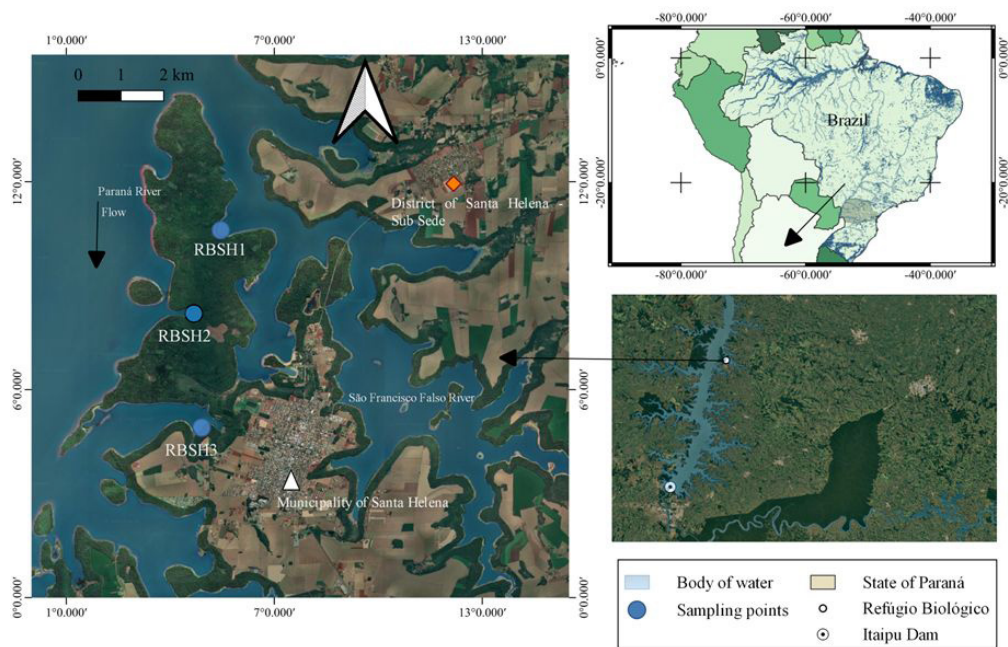
Figure 1. Study area with the location of sampling points in the Refúgio Biológico de Santa Helena, Itaipu Reservoir, Paraná III River Basin,